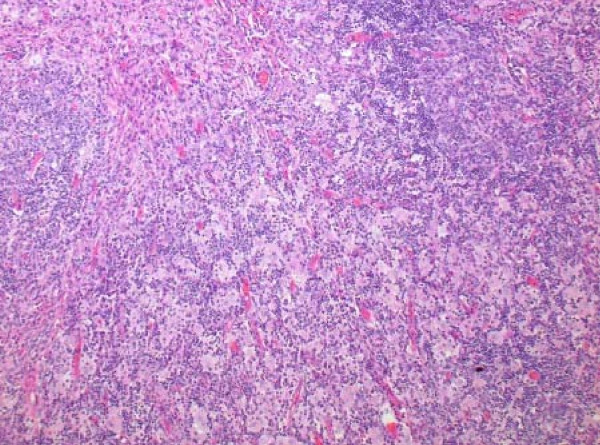
Lower power showing large epithelioid histiocytes scattered throughout the Paracortex.